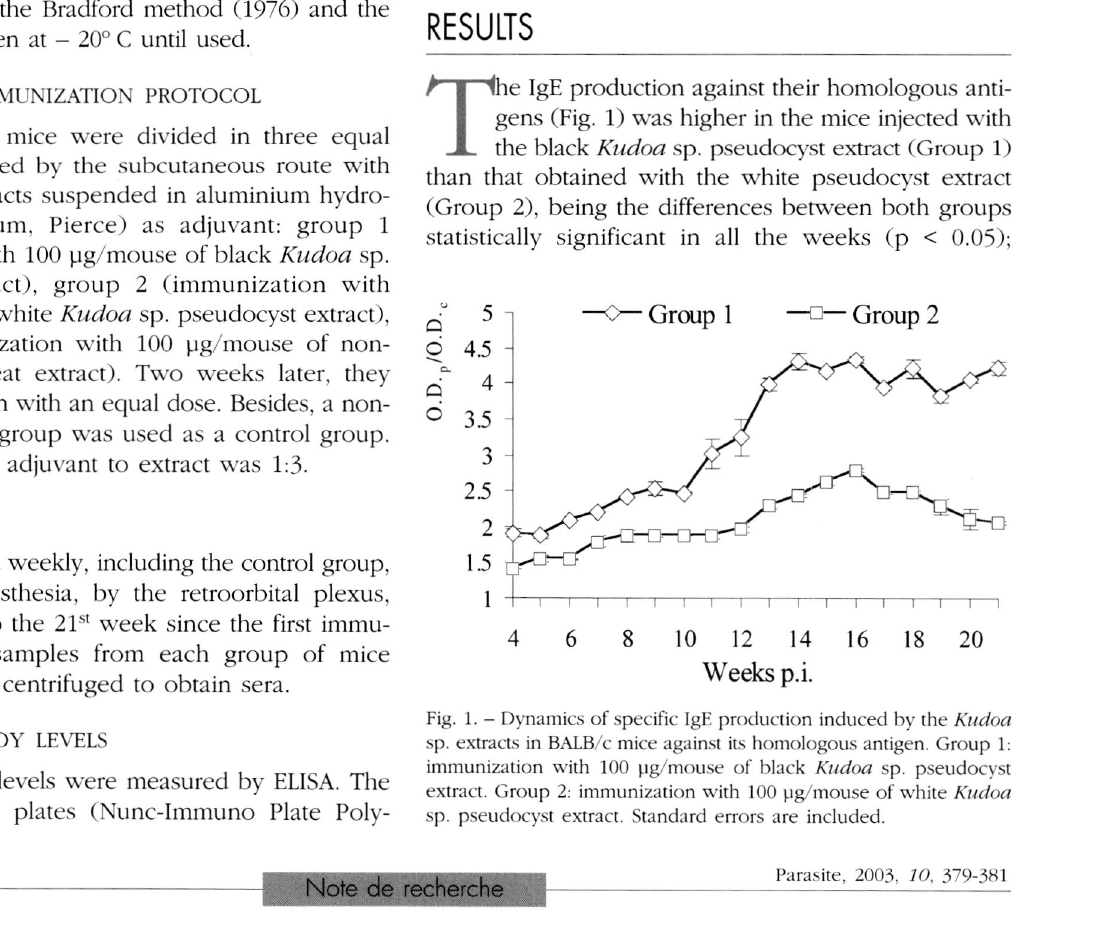
Fig. 1. - Dynamics of specific IgF production induced by the Kudoa sp. extracts in BALB/c mice against its homologous antigen. Group 1: immunization with 100 pg/mouse of black Kudoa sp. pseudocyst extract. Group 2: immunization with 100 µg/mouse of white Kudoa sp. pseudocyst extract. Standard errors are